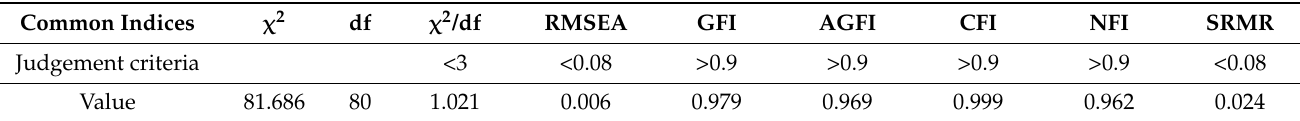
Figure 4. First-order CFA model. Figure 5. First-order CFA model. Table 7. Adaptation indices of the first-order CFA model.